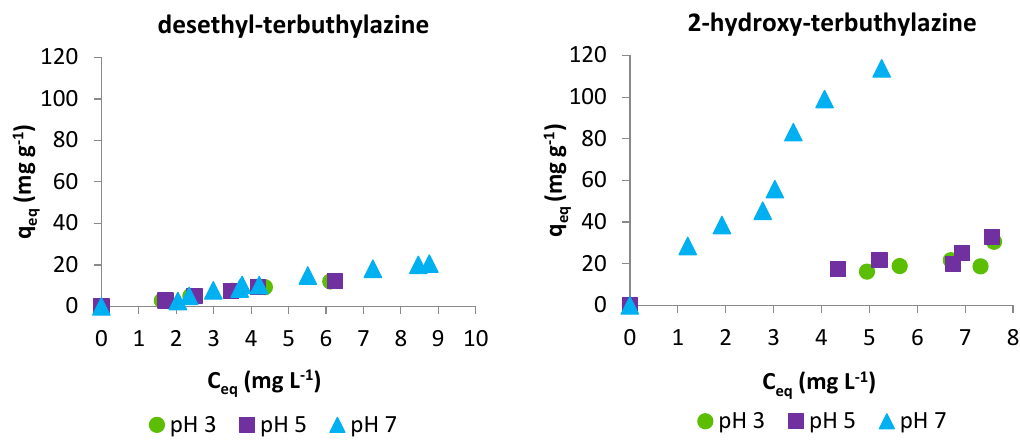
Figure 5. Adsorption isotherms for desethyl-terbuthylazine and 2-hydroxy-terbuthylazine on microspheres having carboxyl groups groups in acidic (p(DVB)-COOH) and sodium (p(DVB)-COONa) forms. in acidic (p(DVB)-COOH) and sodium (p(DVB)-COONa) forms.